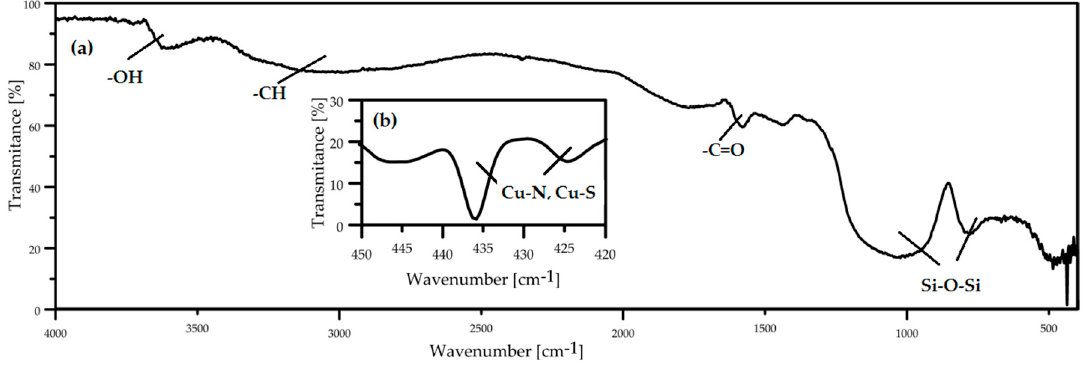
Figure 12. FTIR spectrum of laccase biocoating in range of wavenumbers from 4000 to 400 cm − 1 ( a ) and 420 to 450 cm − 1 ( b ).